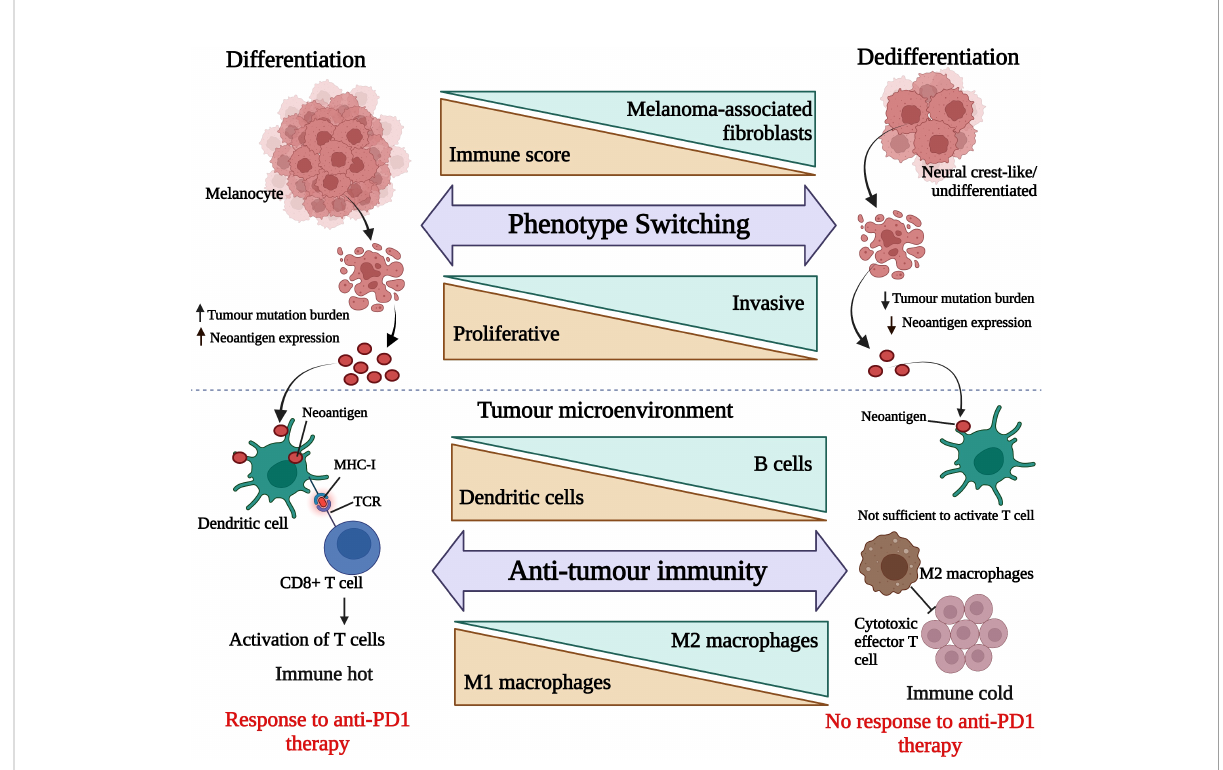
FIGURE 9 Hypothetical presentation of responding tumour microenvironment versus non-responding tumour microenvironment. The upper panel is representing melanoma de-differentiation trajectory and the lower panel is focusing on the interplay between melanoma cell types and immune cell composition. This image was generated using